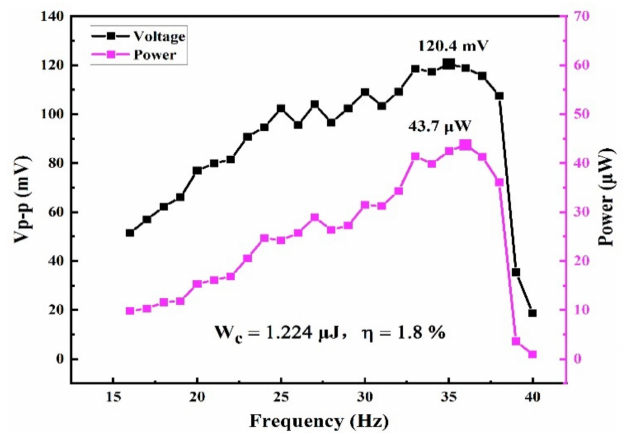
Figure 7. Experimental results of peak-to-peak voltage and average power output.